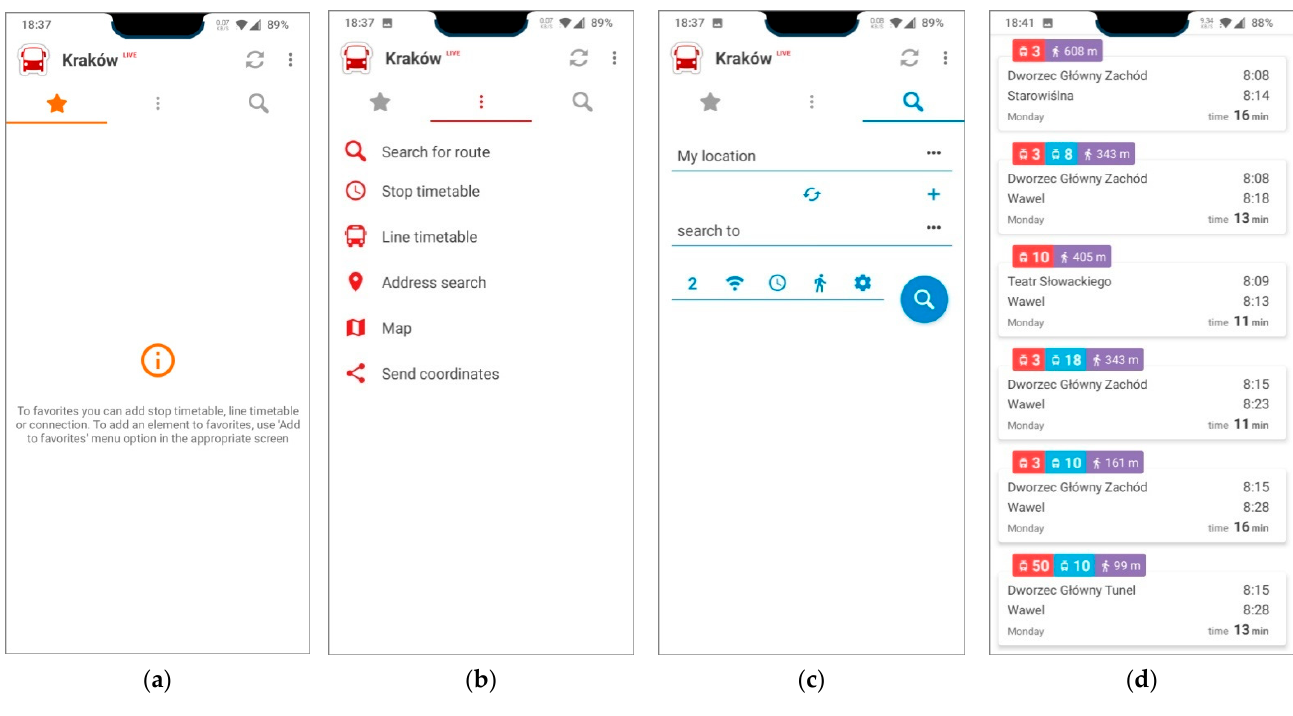
Figure 6. Overview of the tabs and information windows of the BusNavi application: ( a ) favourites; ( b ) redirection to connections, timetable from a given stop, available city bike stations nearby, address finder, maps and the possibility of sending the coordinates of where the user is located; ( c ) defining the start and end point and setting the trip parameters; ( d ) information window for suggested variants of trip routes.